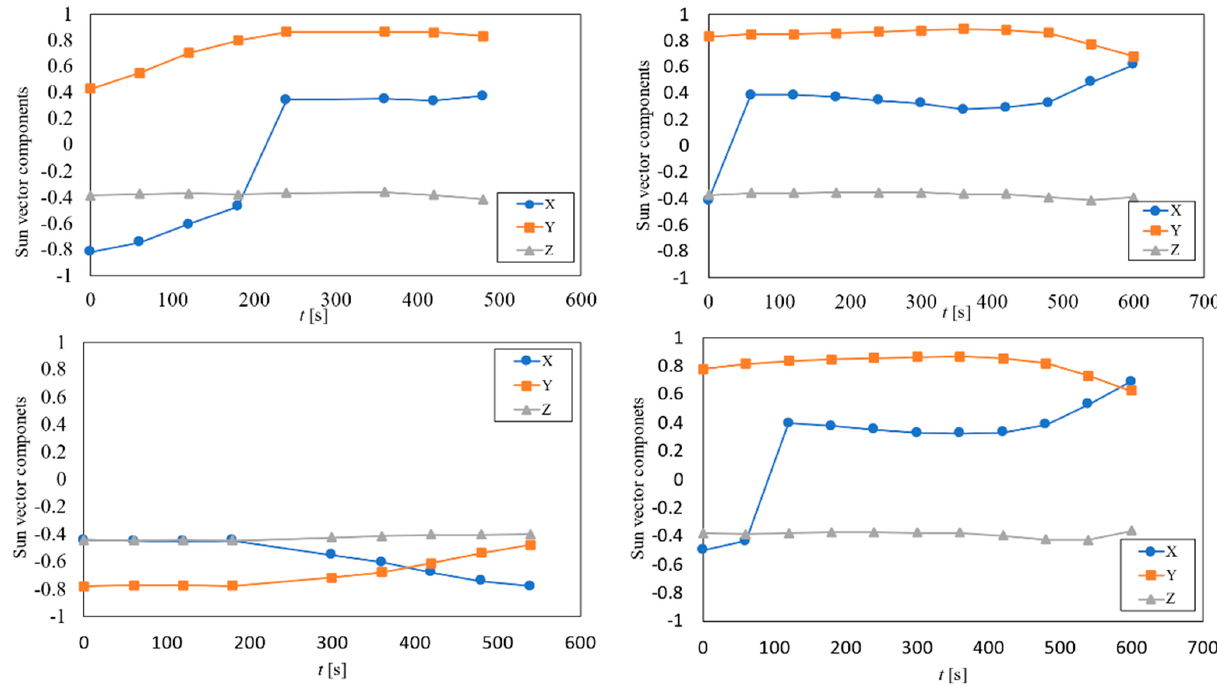
Figure 13. Calculated sun vector components for the illuminated accesses of the first three days of mission.